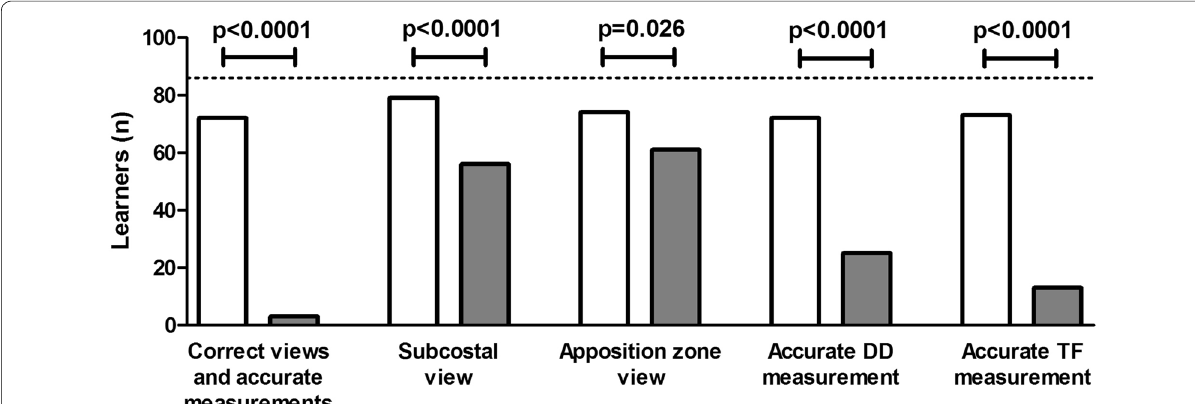
Fig. 1 Number of learners reaching the study aims. From left to the right, the figure depicts the number of learners that: (1) correctly detected both acoustic windows and performed accurate measurements (first outcome); (2) correctly identified the subcostal view; (3) correctly identified the apposition zone; (4) accurately performed the DD measurement; and (5) accurately performed the TF measurement. White bars represent the intervention group while grey ones the control group. The dashed line represents the total number of learners randomized per group ( n